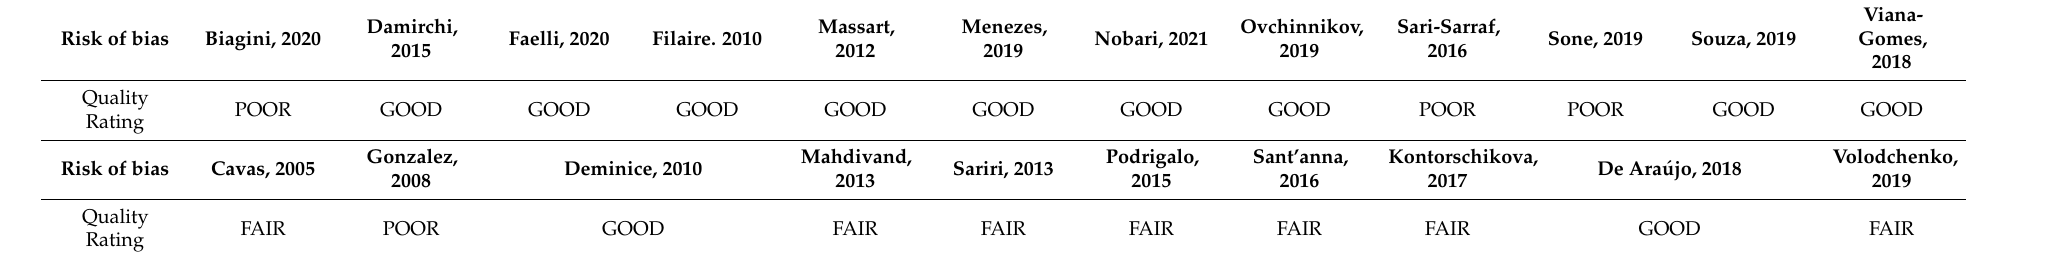
Table 2. Quality Assessment Tool for Before-After (Pre-Post) Studies with No Control